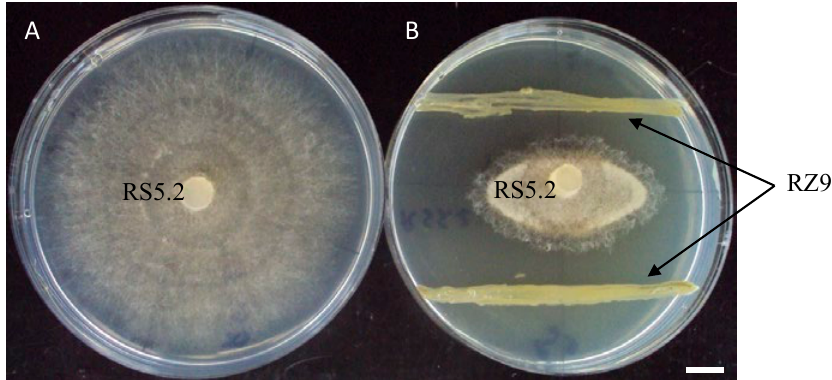
Figure 1. In vitro antibiosis activity of strain RZ9 of Pseudomonas aeruginosa against the strain RS5.2 of Rhizoctonia solani on PDA after 4 d incubation at 25°C. A, control; B, antagonistic activity of strain RZ9. Bar = 1